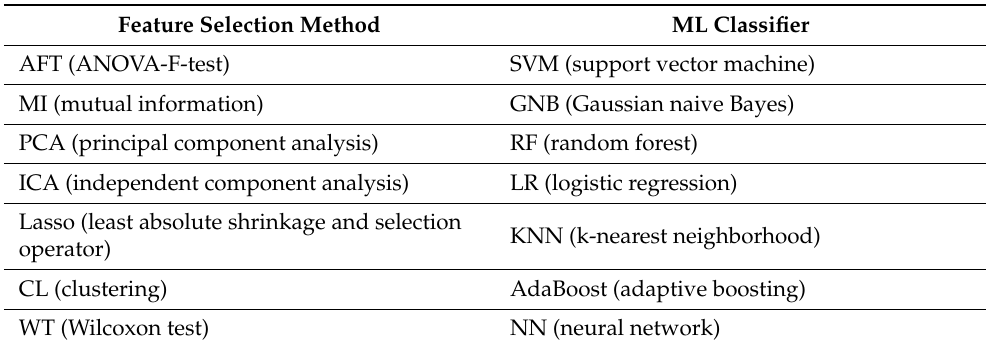
Table 1. Feature selection and classification methods that were used to obtain the predictive